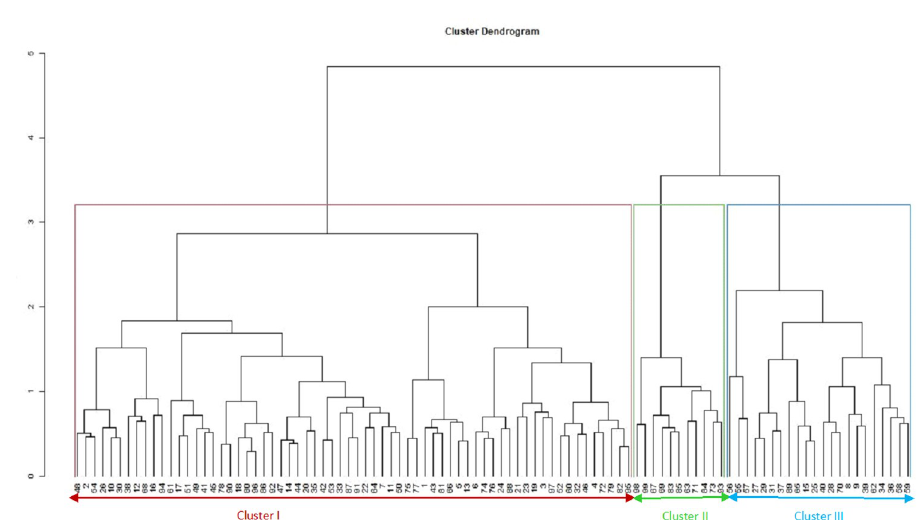
Fig 6. Dendrogram showing relatedness among the 99 groundnut genotypes based on combined matrix.